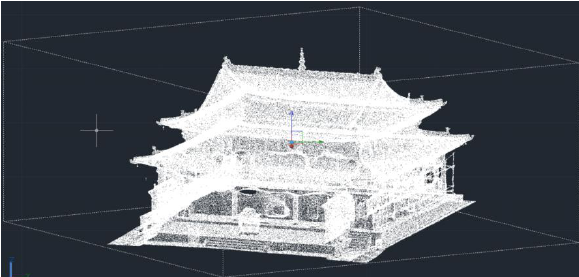
Figure 4 . Point cloud data processing of Baoguang hall: (a) Irregular triangulation generated by the point cloud; (b) blank model; (c) texture mapping to the 3D model; (d) 3D model.